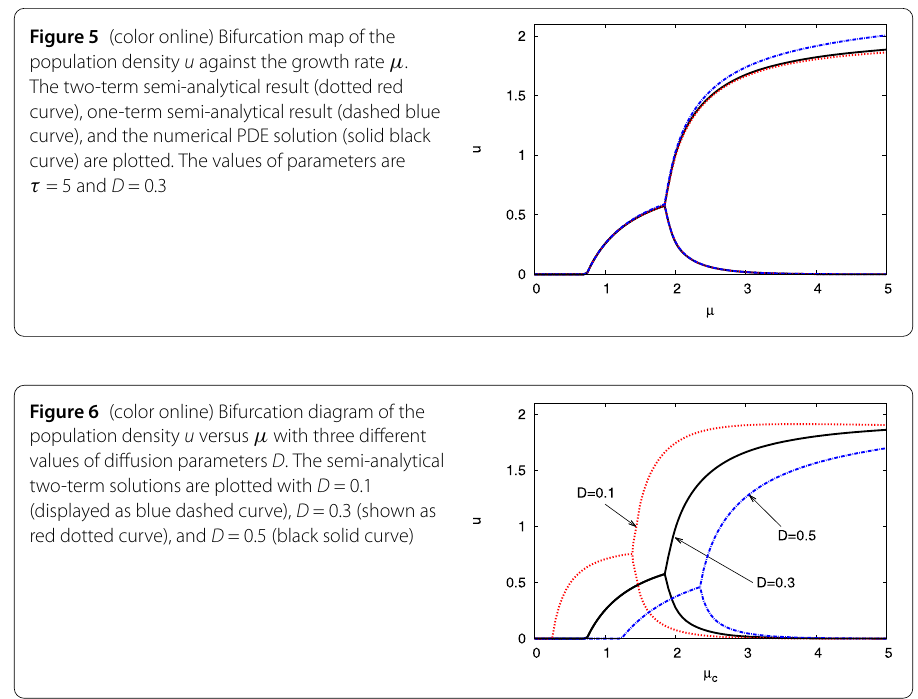
Figure 5 (color online) Bifurcation map of the population density u against the growth rate μ . The two-term semi-analytical result (dotted red curve), one-term semi-analytical result (dashed blue curve), and the numerical PDE solution (solid black curve) are plotted. The values of parameters are τ = 5 and D = 0.3